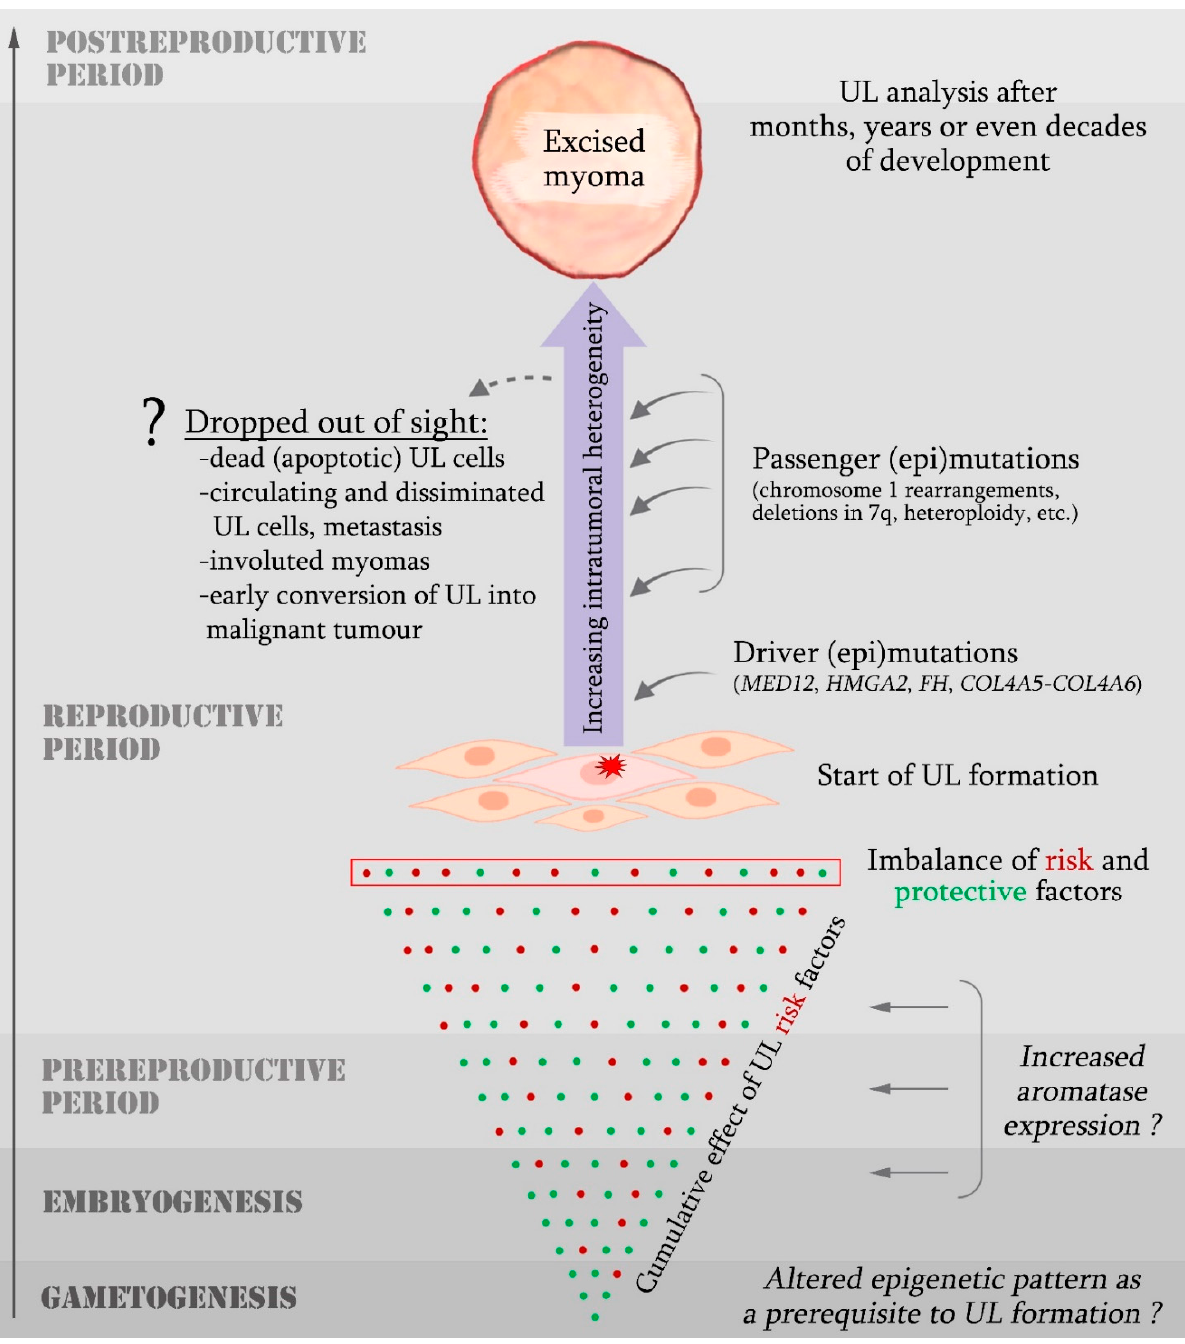
Figure 2. The hypothetic timeline of uterine leiomyoma (UL) genesis. A prerequisite to UL formation may appear in parental gametogenesis and could be presented by altered epigenetic patterns in oocytes or spermatozoa. The accumulation of UL-associated negative effects during ontogenesis can lead to an acute imbalance of risk and protective factors and the beginning of UL formation. UL growth takes a long period of time, during which driver ( MED12 and FH mutations, HMGA2 rearrangements and overexpression, COL4A5 - COL4A6 rearrangements) and passenger (7q deletions, chromosome 1 rearrangements, heteroploidy, etc.) changes occur and contribute to the intratumoral heterogeneity.